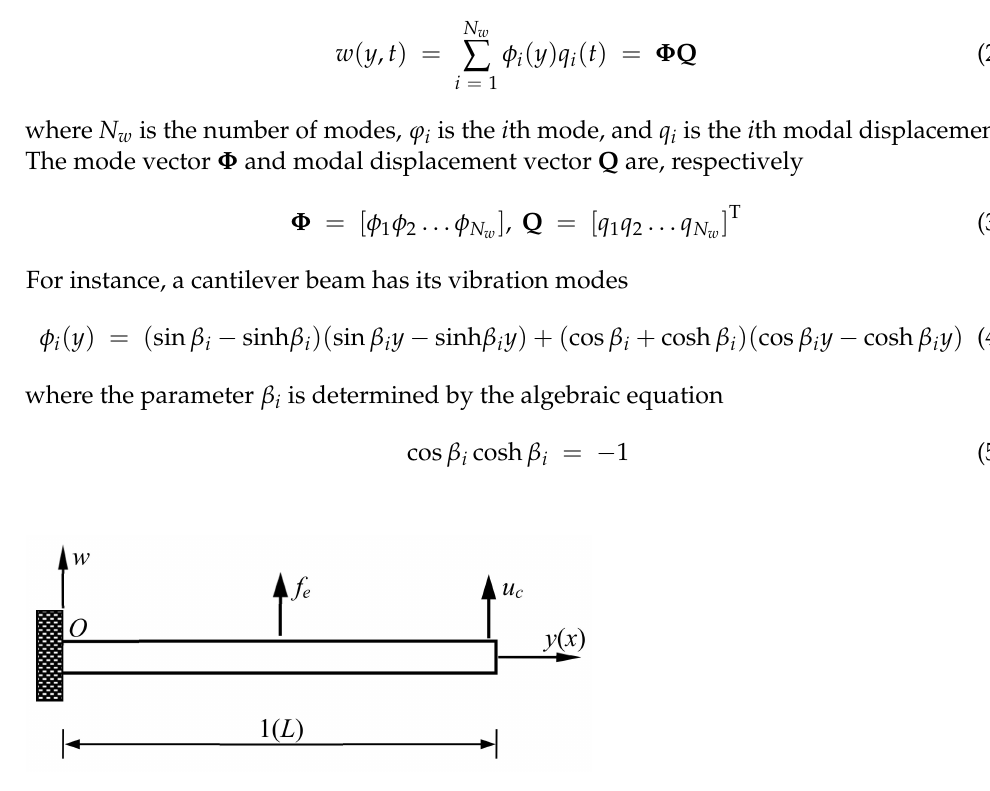
Figure 1. Meso-scale beam with control u c under loading f e